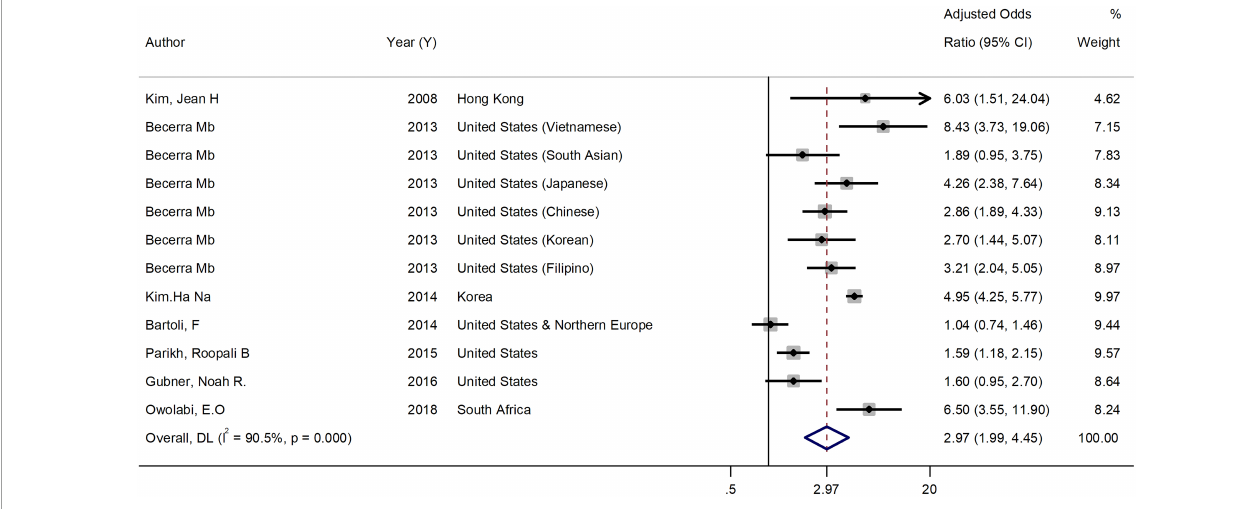
FIGURE2 Forest plot of the association between binge drinking and current smoking. Weights are from random-effects model.